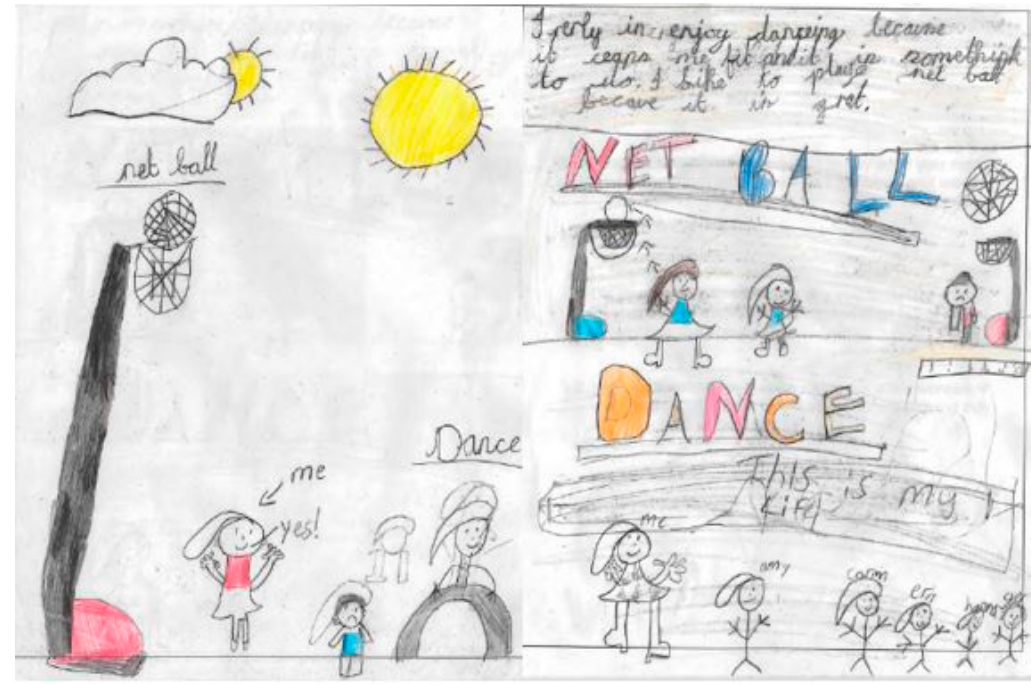
Figure 5. Drawing from Sophie, aged 8, illustrating out-of-school PA. “In my drawing, I’ve got me, I’ve got my friends, and I’ve got things at the park. I really enjoy street dance because it’s something I do. And then netball, I like to play netball because it is great. Sometimes at after school clubs, sometimes Miss picks us to go in the front, but sometimes you can go at the back. But I’ve been in the front. But I’m mainly at the back” [Sophie Smith].